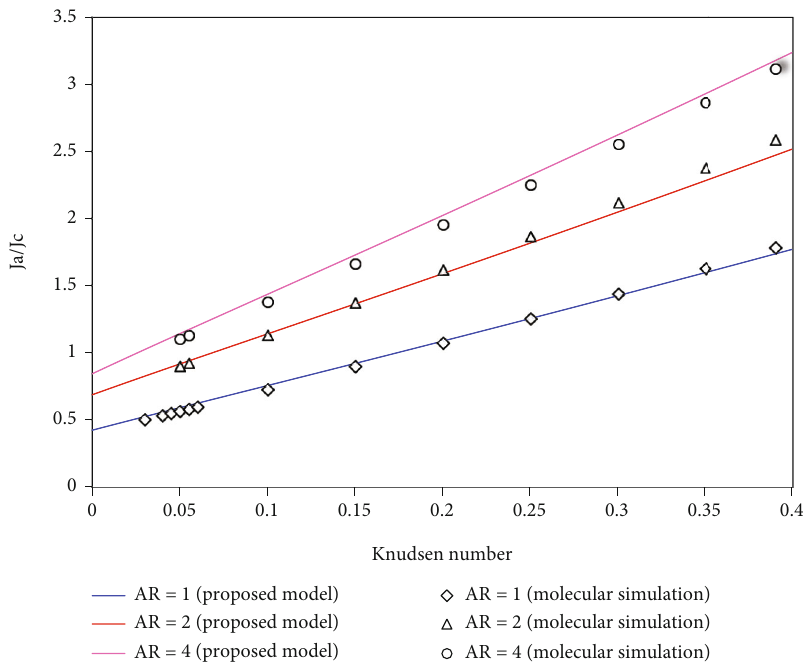
Figure 3: Comparison between proposed model and molecular simulation with low Kn .